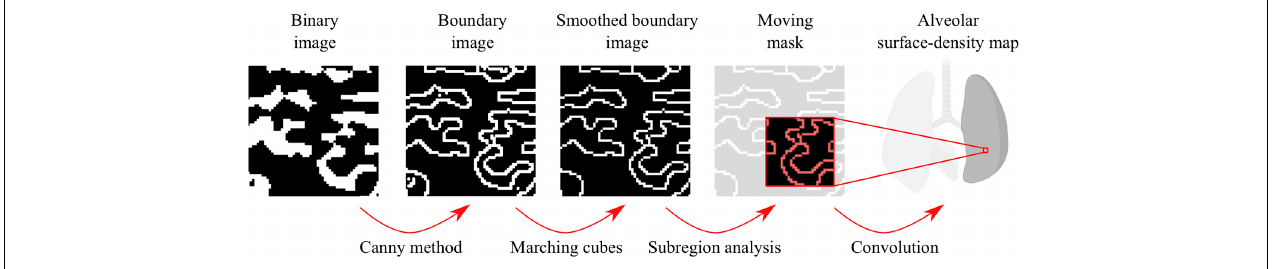
FIGURE 2 | Workflow for the construction of alveolar surface-density maps. TABLE 1 | Alveolar morphological parameters for the representative volume elements (RVE) samples. Group